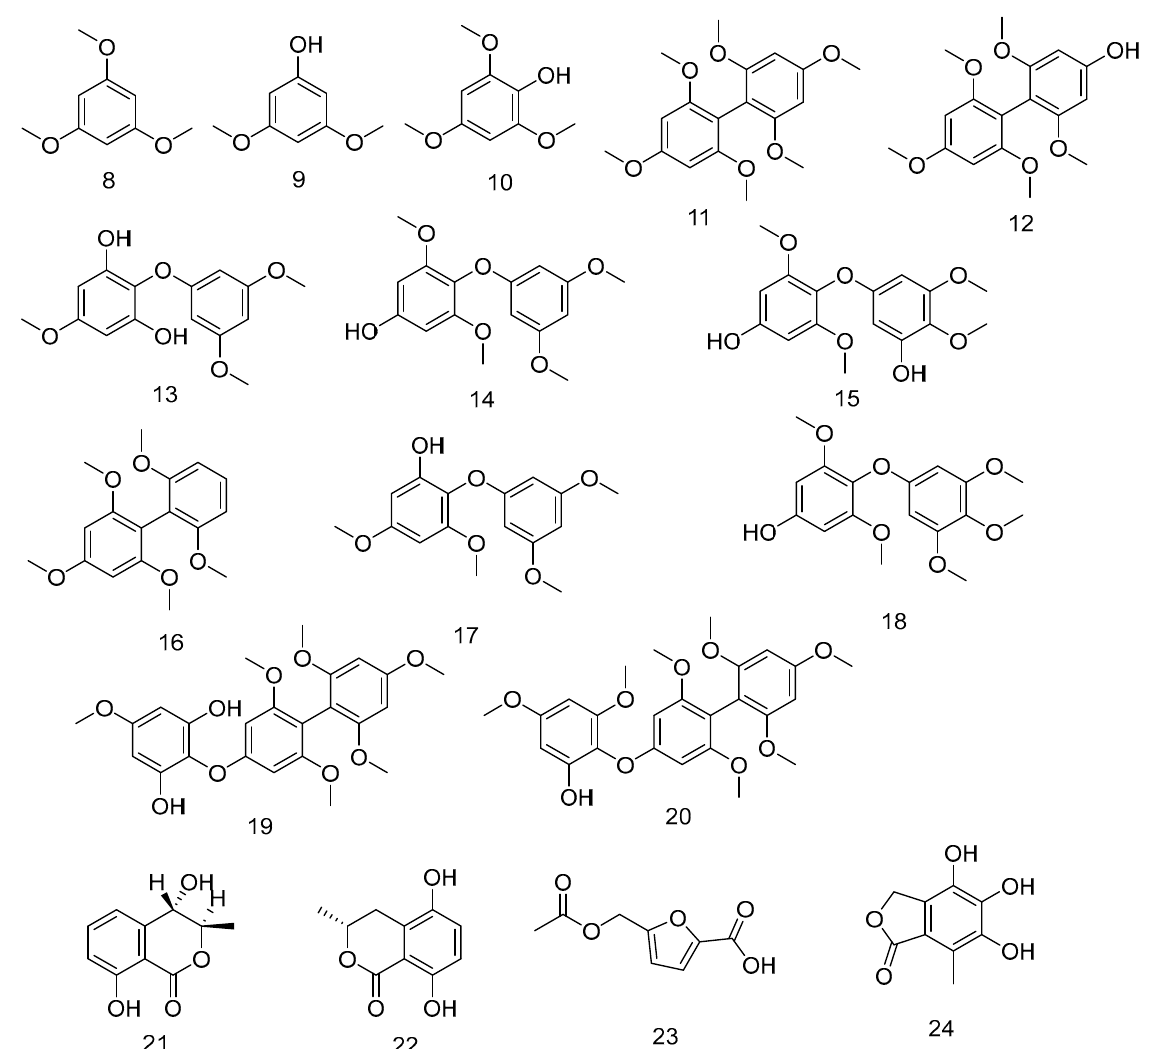
Figure 7. Compounds from 8 – 24 (Polyphenolic, isochromane, 2-furoic acid derivatives). Phytosterols present in brown seaweeds have a important medicinal effects in lowering total cholesterol and harmful low-density lipoproteins [182]. A galactolipid compound 27 and 3,7,11-Trimethyl-2-dodecen-1-ol 28 were detected from F. vesiculosus , and other glycolipids detected from F. vesiculosus are compounds 29 and 30 [185,186] Figure 8 shows the compounds from 25 – 30 .